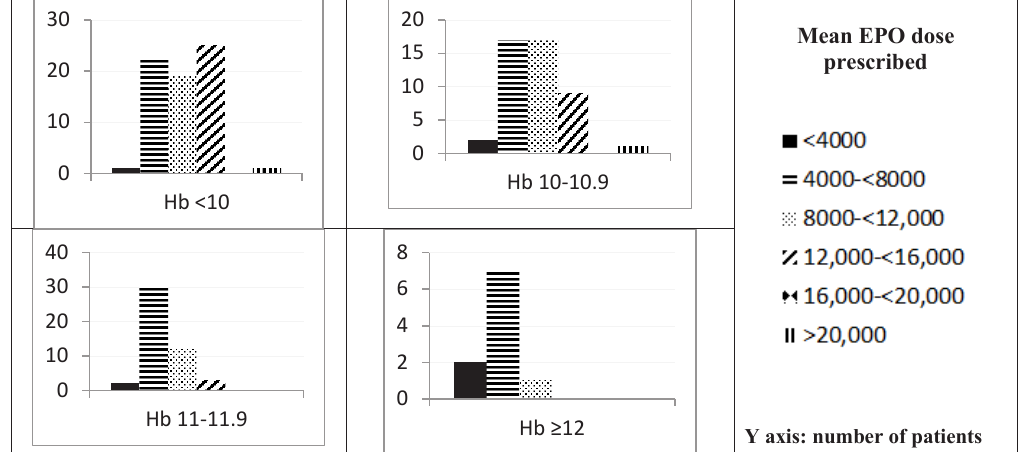
Mean EPO dose prescribed